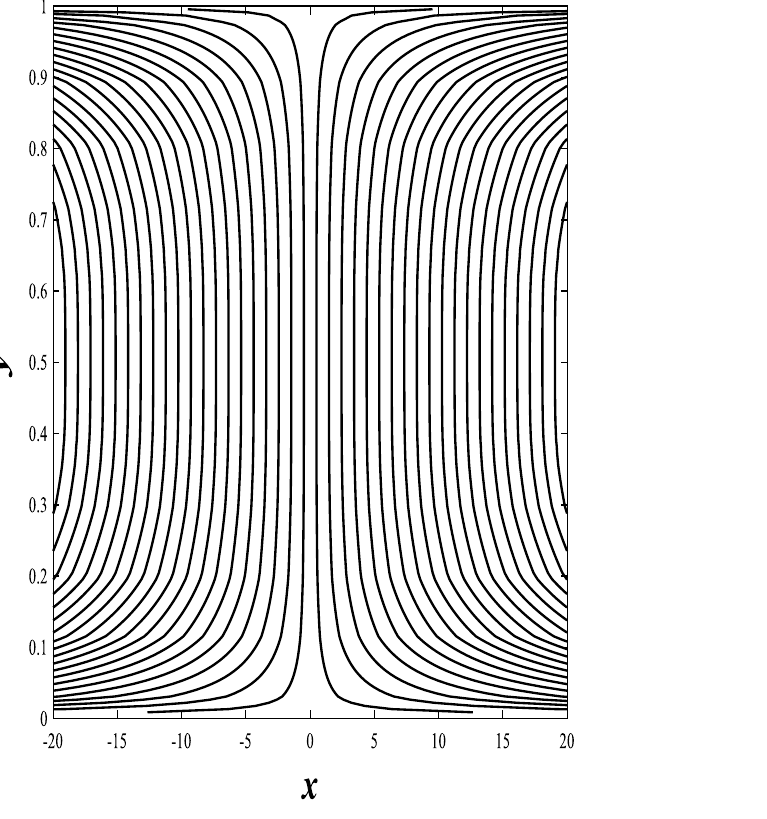
Figure 31. Stream lines profile at F =